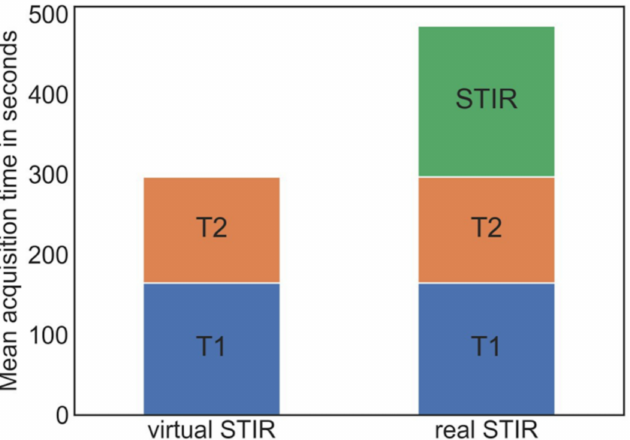
Figure 4. Diagram of the mean acquisition times with (left) and without STIR sequence.